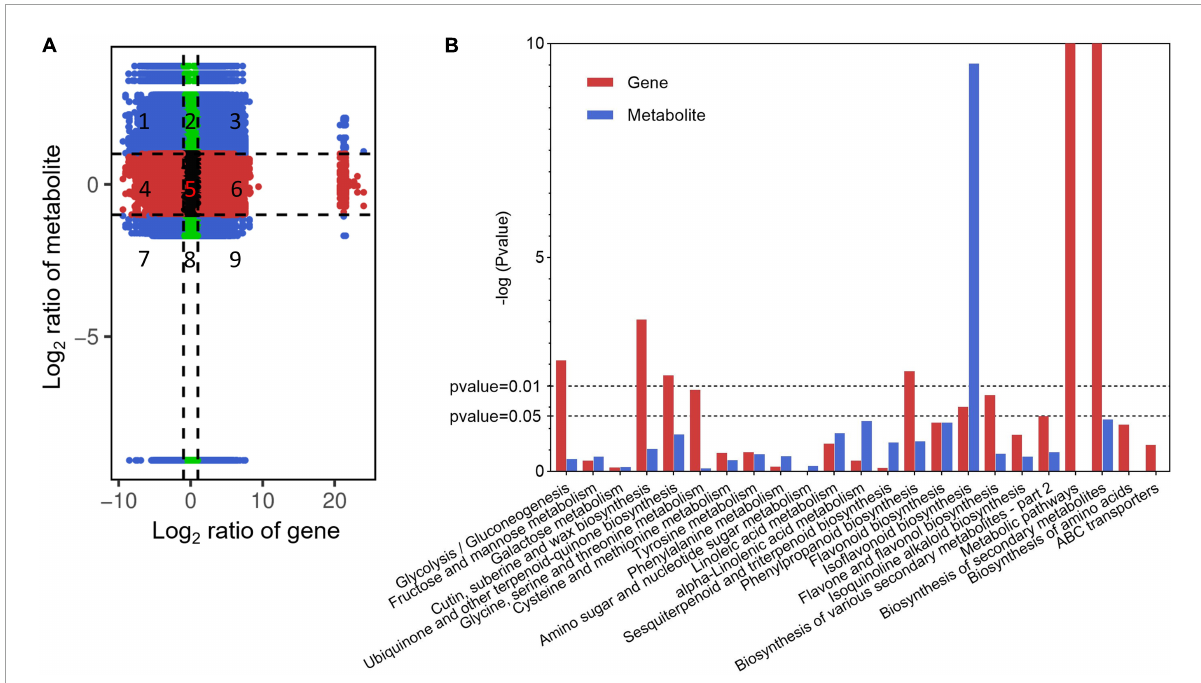
FIGURE4 Profiles of the association analysis of genes and metabolites in green vs. yellow alfalfa sprouts. (A) Nine-quadrant map of genes and metabolites. (B) KEGG enrichment analysis of differential metabolites and genes between green and yellow alfalfa sprouts. The x -axis represents the metabolic pathway. The y -value represents the -log ( P -value) of differentially expressed genes (DEGs) and differentially accumulated metabolites